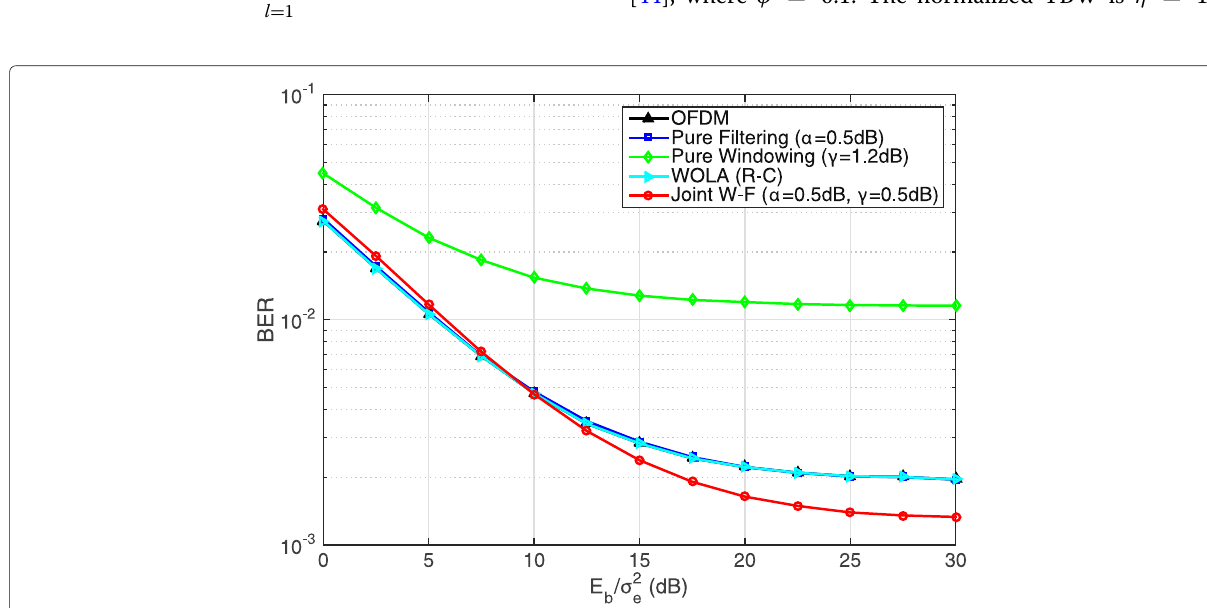
Fig. 13 Multi-user BER performances with CFOs